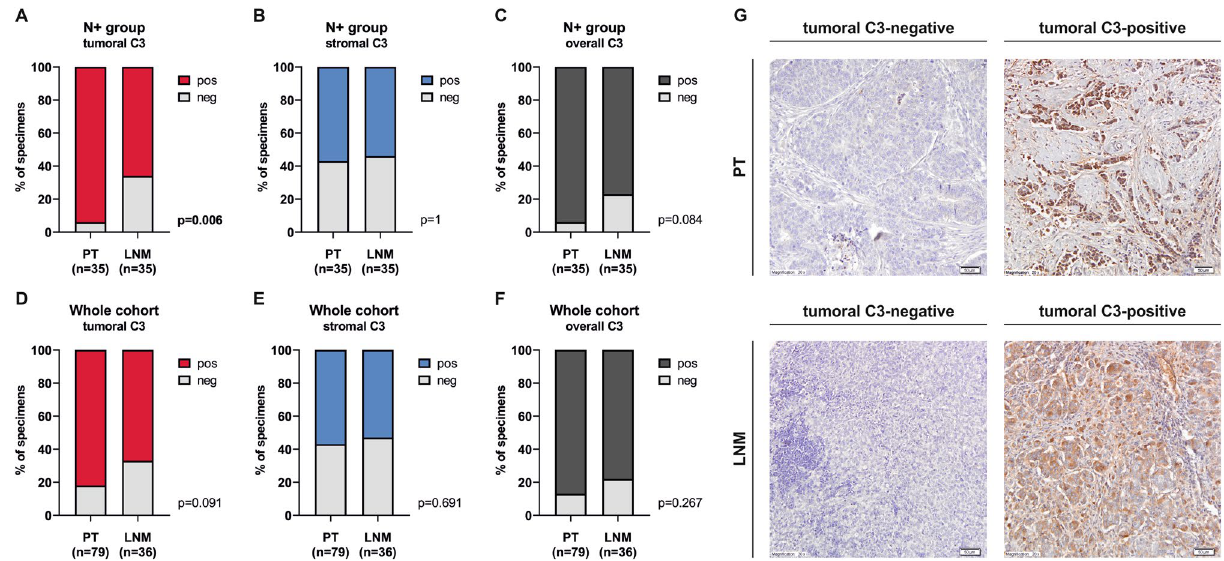
Figure 4. C3 protein expression is reduced during the lymphatic spread of BCa. N+ group evaluated for tumoral ( A ), stromal ( B ) and overall ( C ) C3 expression in PT and LNM; whole cohort evaluated for tumoral ( D ), stromal ( E ) and overall ( F ) C3 expression in PT and LNM; number of informative specimens is presented in Supplementary Figure S4; distribution was estimated with Fisher’s exact test. Representative images of C3 immunohistochemical staining in PT and LNM ( G ); presented tumoral C3-positive tissues also show a weak stromal C3